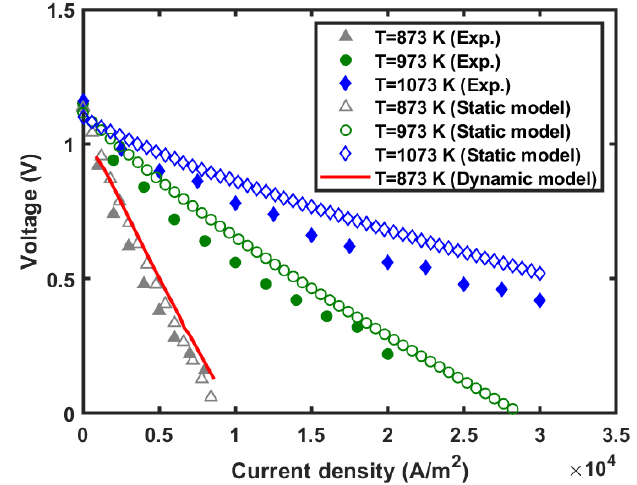
Figure 3. Comparisons between the I–V curve data of a SOFC system obtained from three sources: experimental data excerpted from [31], simulation data obtained from the static electrochemical model presented in this study, and simulation data obtained from the dynamic model stated in this study.